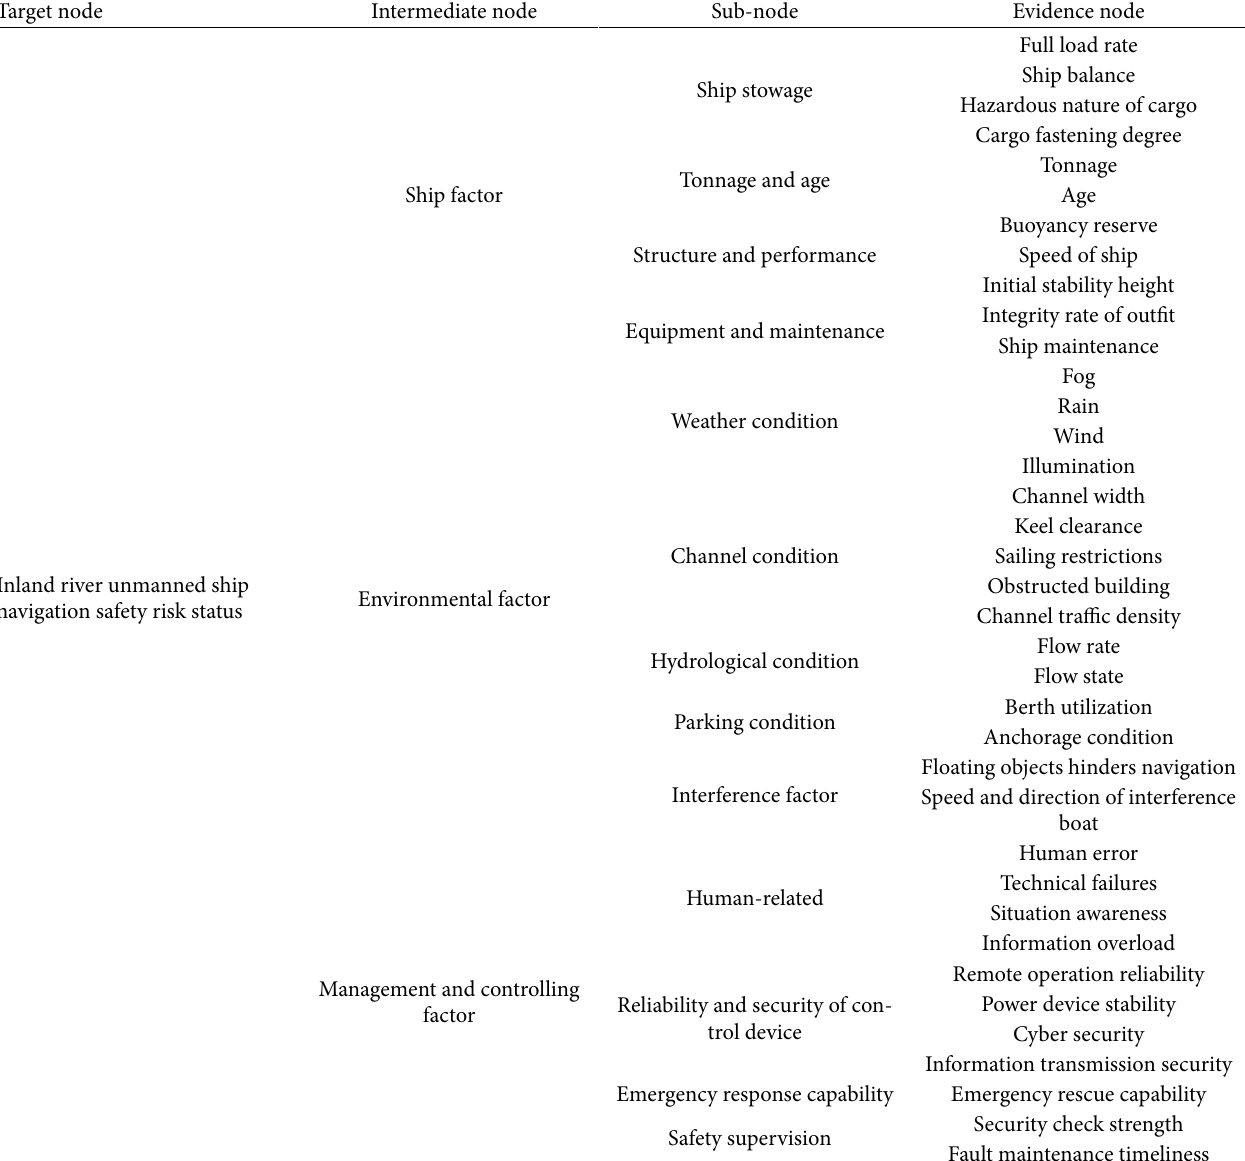
Table 3: Node table at each level of Inland river unmanned ship navigation safety risk